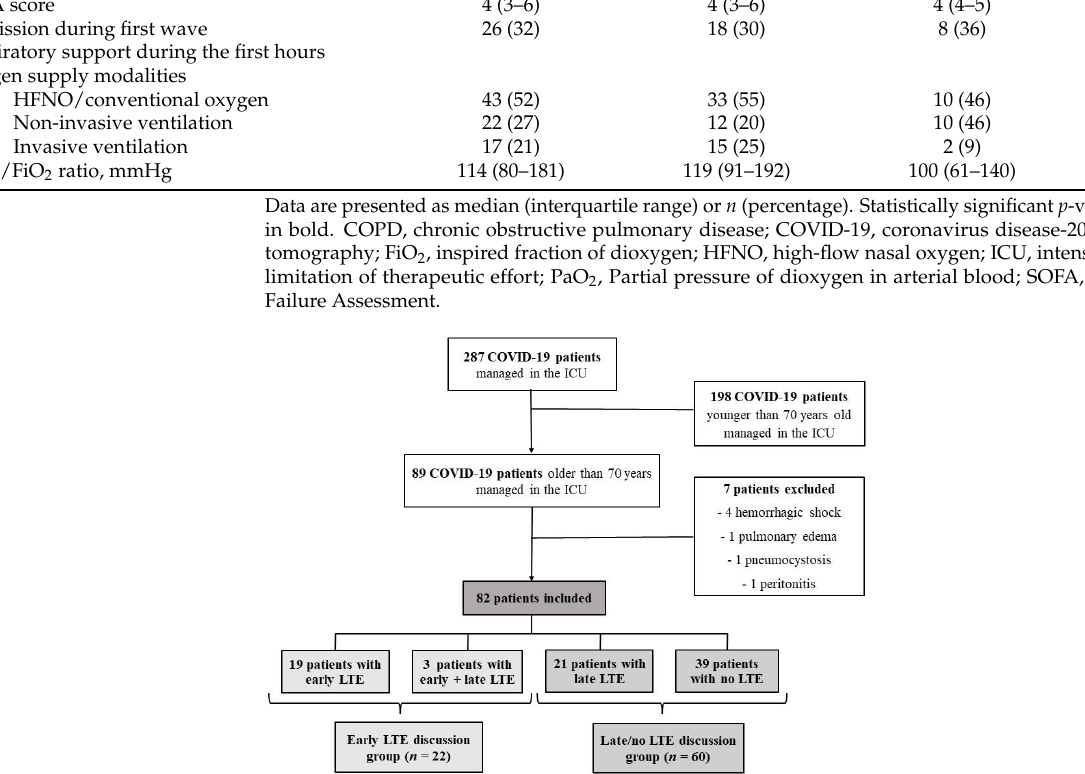
Figure 1. Study flowchart. COVID-19, coronavirus infectious disease-2019; ICU, intensive care unit. Table 1. Characteristics of 82 critically ill COVID-19 elderly patients on intensive care unit admis- sion according to the early versus non-early discussion of limitation of therapeutic effort.